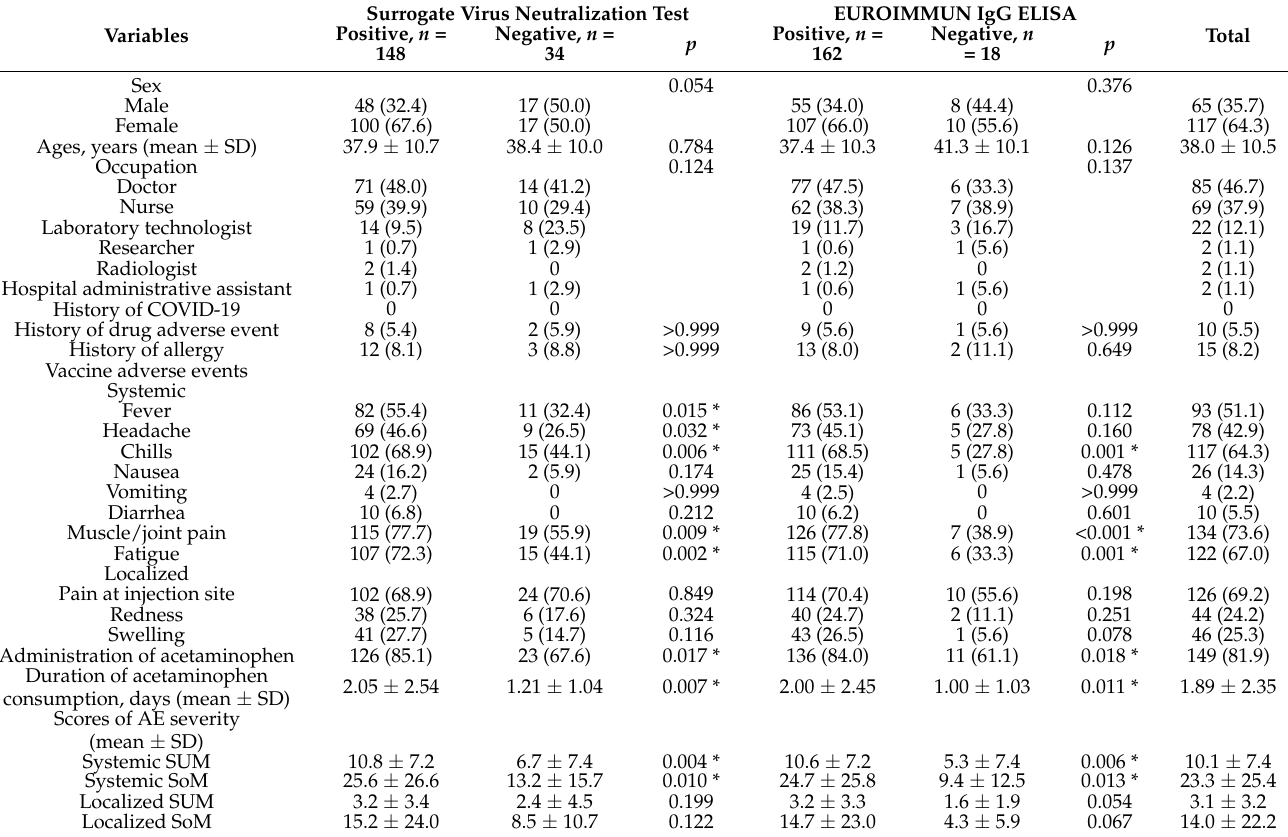
Table 1. Demographics and vaccine adverse event serological